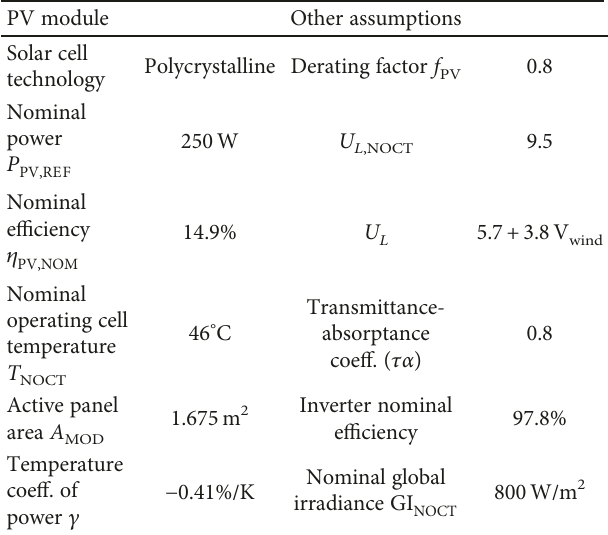
Table 2: Main parameters of PV